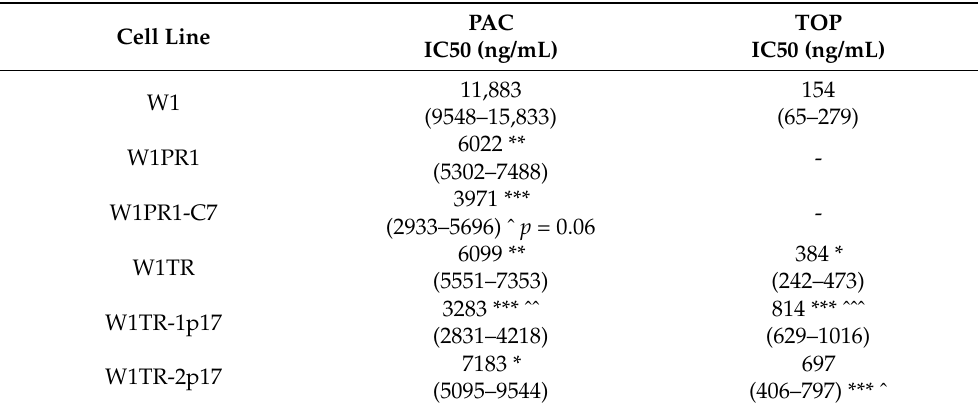
Table 2. Summary of cell line resistance to PAC (paclitaxel) and TOP (topotecan) in three-dimensional (3D) cell culture condition.